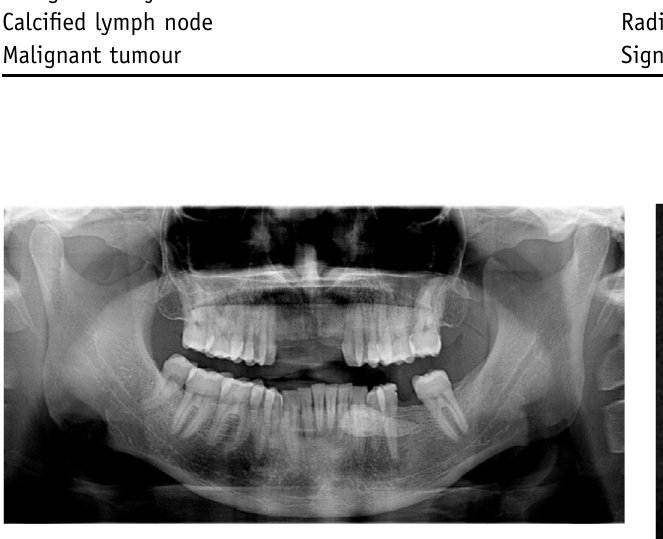
Fig. 7. Example of a panoramic X-ray showing a mandibular salivary stone.